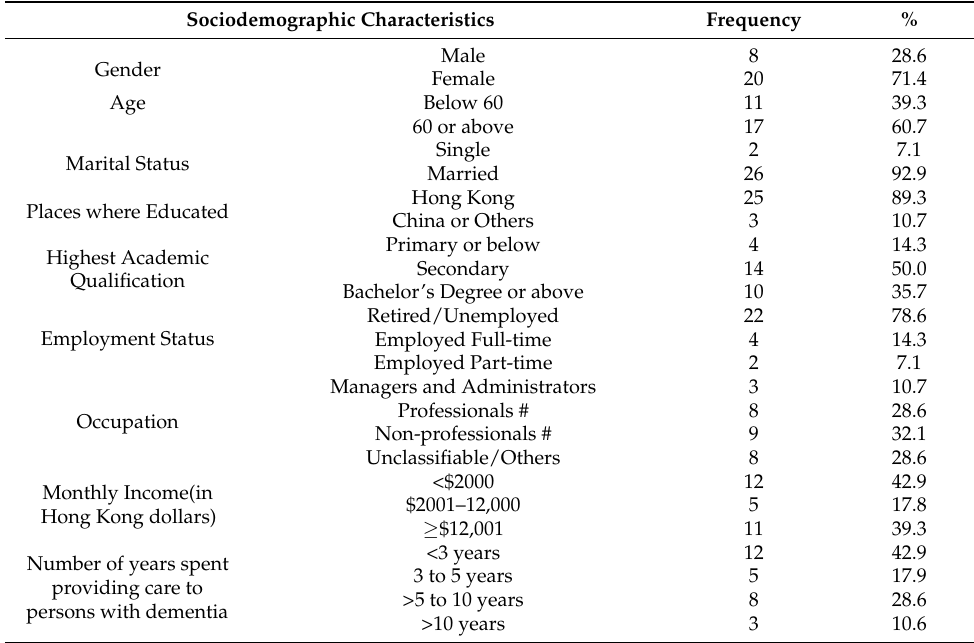
Table 1. Characteristics of the participants in the 8-week intervention.